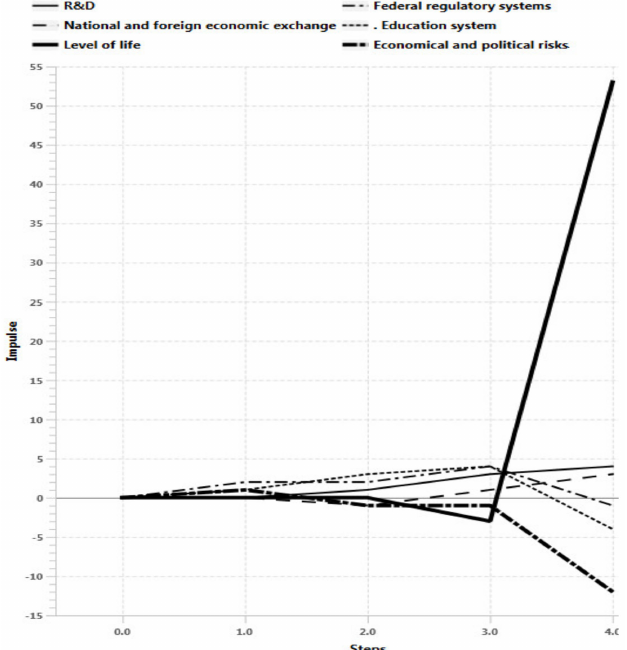
Figure 15. The graph of impulse processes at the selected vertices V6, V7, V10, V12, V16, V20 Scenario "Improving the conditions of higher education and economical and political risks increasing, while federal regulatory system actions are taken" disturbing momentum q6 = + 2, q10 = + 1, q16 = + 1. Scenario 2 results. Improving the conditions of higher education and economical and political risks increasing, while federal regulatory system actions are taken, leads to unsustainable situation of the region in long term prospective ( n > 3), including labor market decrease, regional